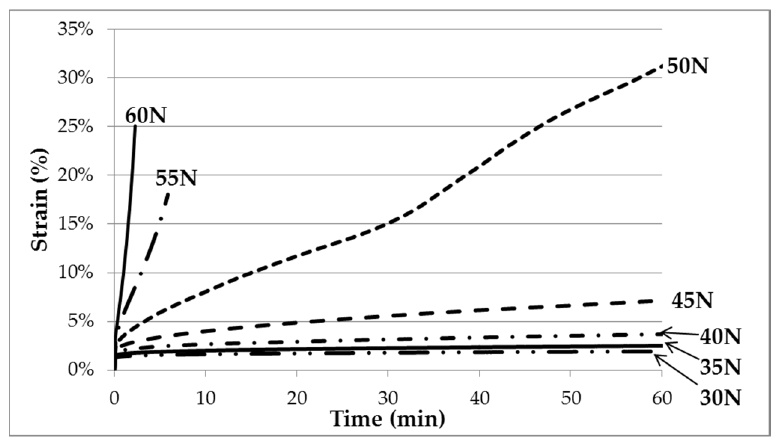
Figure 8. Strain observed in PMMA fibres held at specified load level for 1 h.